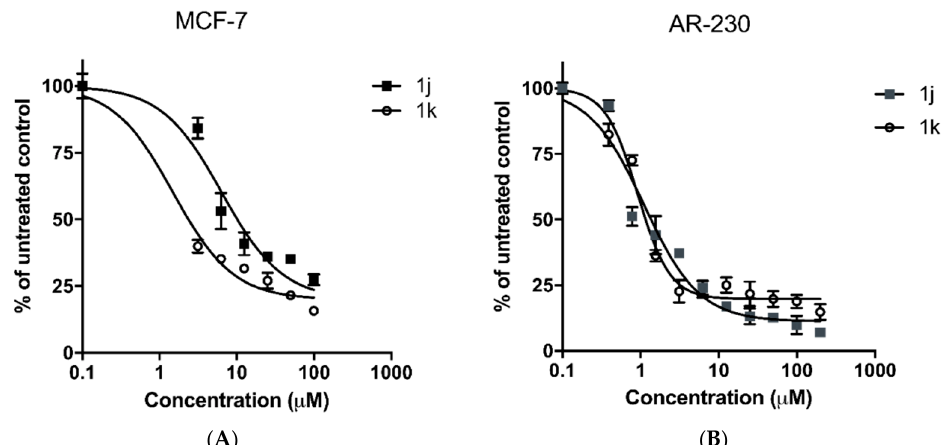
Figure 5. Cell viability of MCF-7 (panel A) and AR-230 (panel B) cell lines following 72h exposure to the lead compounds 1j and 1k as assessed by MTT-dye reduction assay. All groups are compared to an untreated control. Statistical analysis is performed by ANOVA one-way test and Tukey post test.